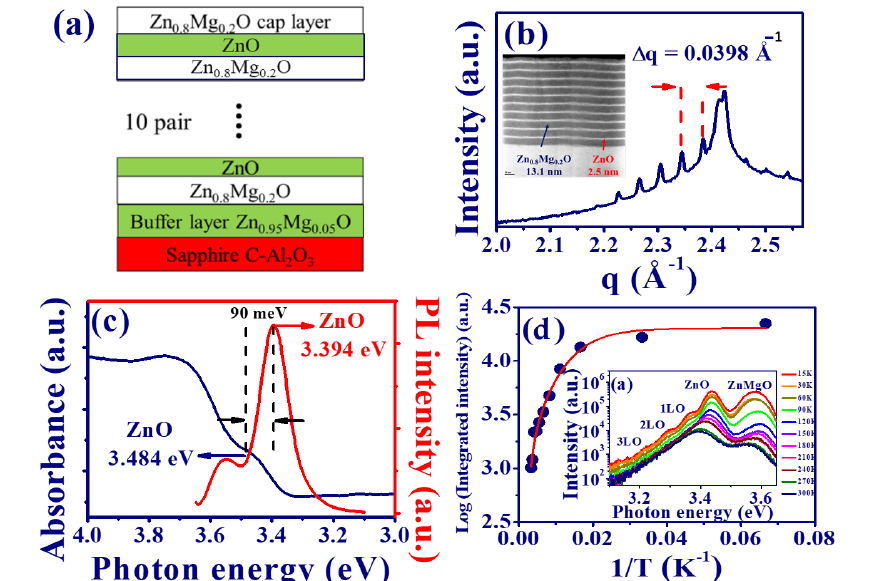
Figure 1. ( a ) Schematic illustration of the structure of the ZnO/Zn 0.8 Mg 0.2 O MQWs, ( b ) X-ray diffraction image (Inset: HAADF-STEM image of the MQWs), ( c ) absorbance (navy solid line), RT-PL spectrum (red solid line), and ( d ) integrated PL intensity as functions of (1/ T ) (Inset:temperature dependent PL spectrum) of the ZnO/ZnMgO